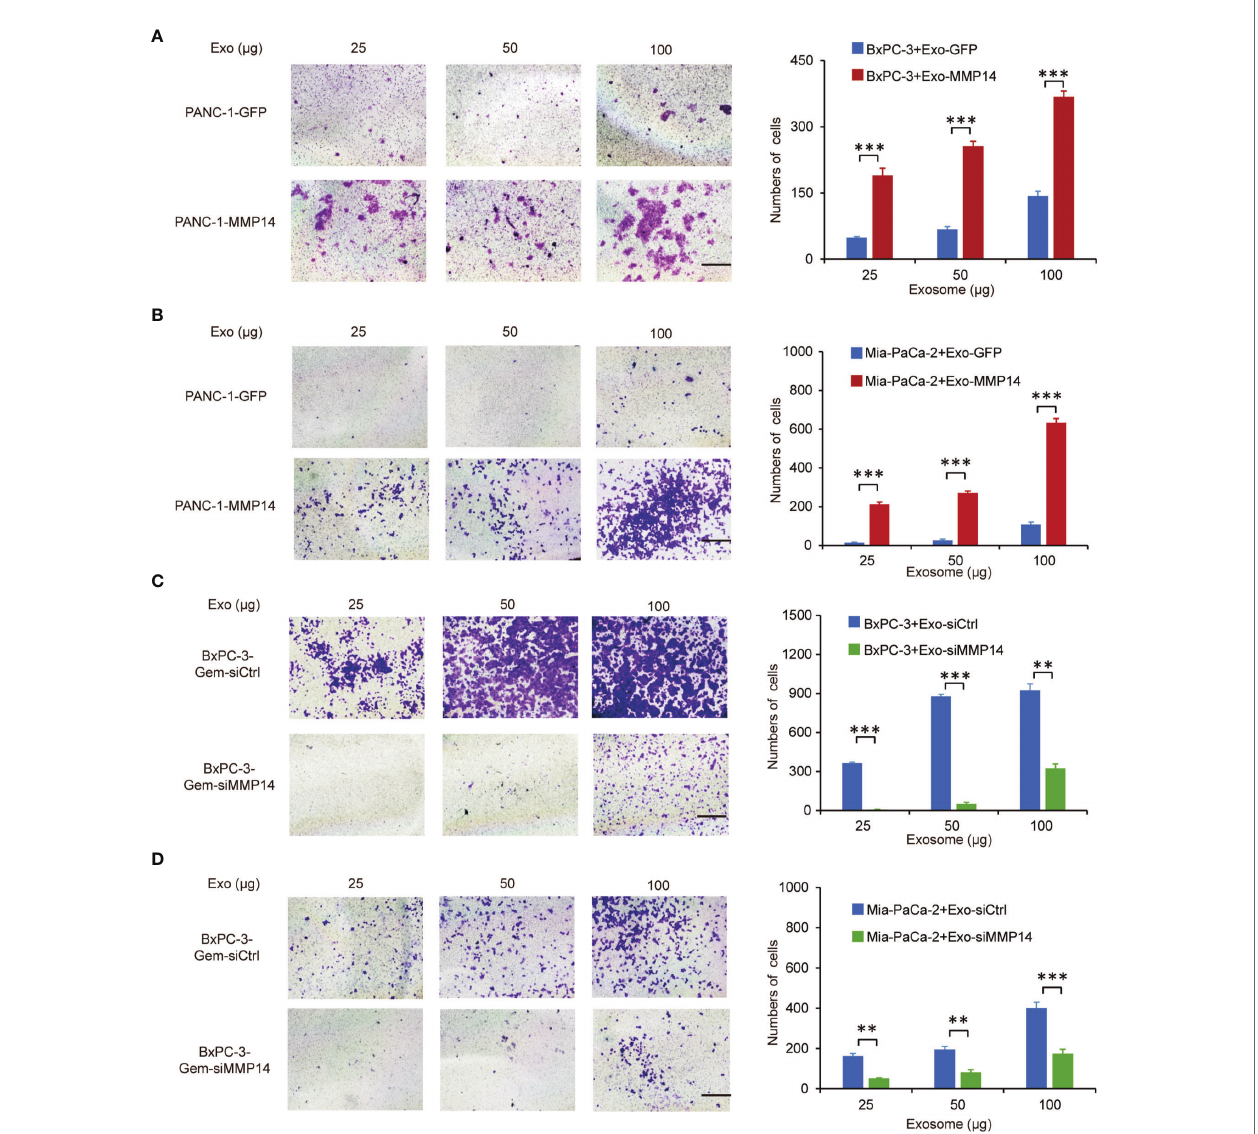
FIGURE 5 | Exosome-transferred MMP14 promotes migration of the sensitive PDAC cells. (A, B) Transwell assay in BxPC-3 (A) or Mia-PaCa-2 (B) cells pre- incubated with indicated exosomes extracted from MMP14-overexpressing or control PANC-1 cells for 48 hours. Representative images from three independent experiments were shown (left) and migrated cells were counted (right). (C, D) Transwell assay of BxPC-3 (C) or Mia-PaCa-2 (D) cells pre-incubated with indicated exosomes extracted from MMP14 knockdown or control BxPC-3-Gem cells for 48 hours. Representative images from three independent experiments were shown (left) and migrated cells were counted (right). Data in A-D are presented as mean ± SD, ** P < 0.01, *** P <